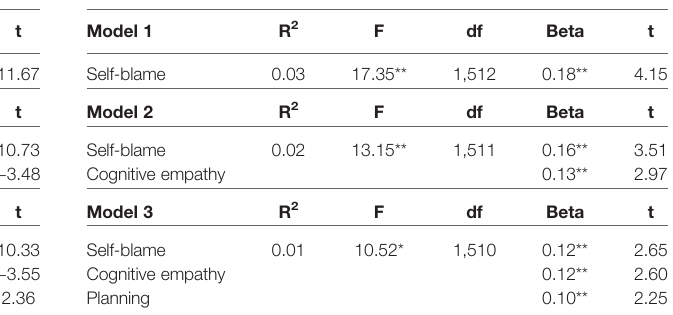
TABLE 4 | Results of linear regression analyses with stepwise extension. Linear regression models of cyberbullying perpetration Linear regression models of